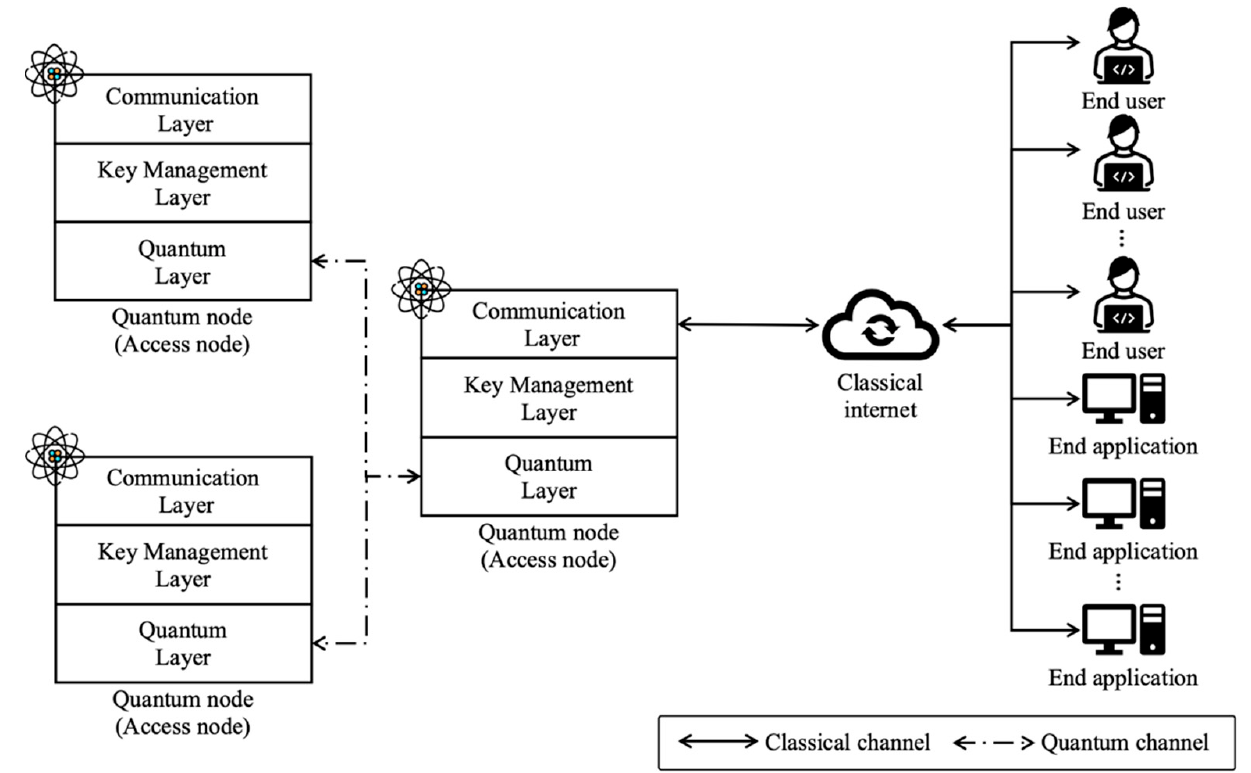
Figure 9. Security interface between the quantum node and end users/applications.